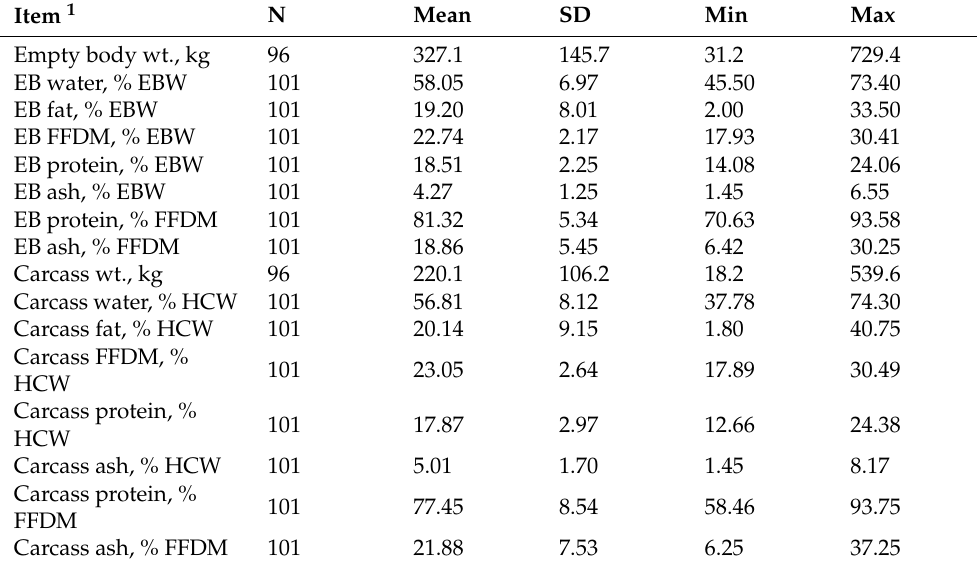
Table 12. Summary statistics of empty body and carcass chemical composition of cattle in the Empty Body-Carcass